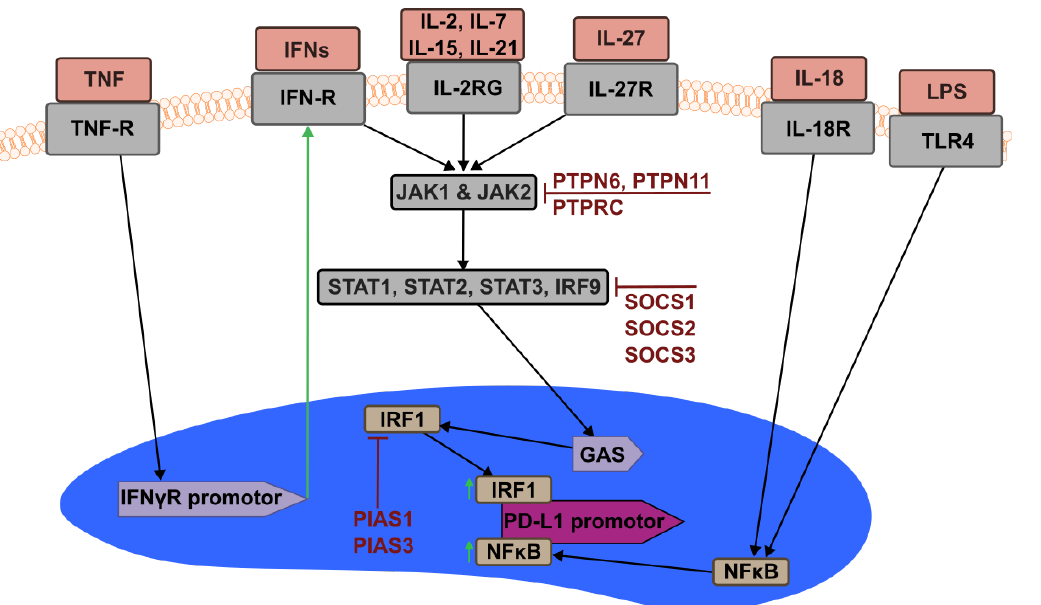
Figure 2. Modulation of PD-L1 Expression through Interferons and Cytokines: PD-L1 expression is initiated via different pathways, with IFN signaling being of major importance. Phosphorylation of STAT factors and subsequent signal transduction into the nucleus trigger expression of IRF1, which in turn activates the PD-L1 promotor. NF κ B, activated via TLR4 signaling or IL-18, can also activate the promotor directly. TNF acts synergistically with IFN via inducing IFN γ receptor expression. PD-L1 expression is attenuated via different inhibitors able to interfere at various signaling steps. The importance of the different modulators differs depending on the cell type; please refer to the text for more detailed explanations. TNF-R: TNF-receptor; IFN-R: IFN-receptor; IL2-RG: interleukin-receptor with common gamma chain. Table 1. Overview of Cytokines and Transcription Factors Relevant for Regulation of PD-L1 Ex- pression.